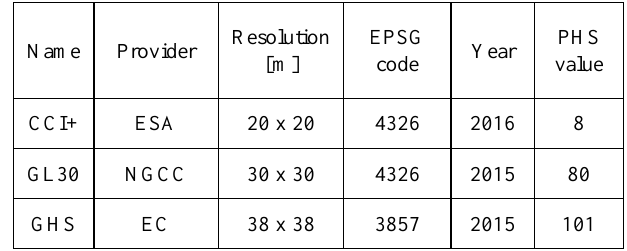
Table 5. Characteristics of different raster data